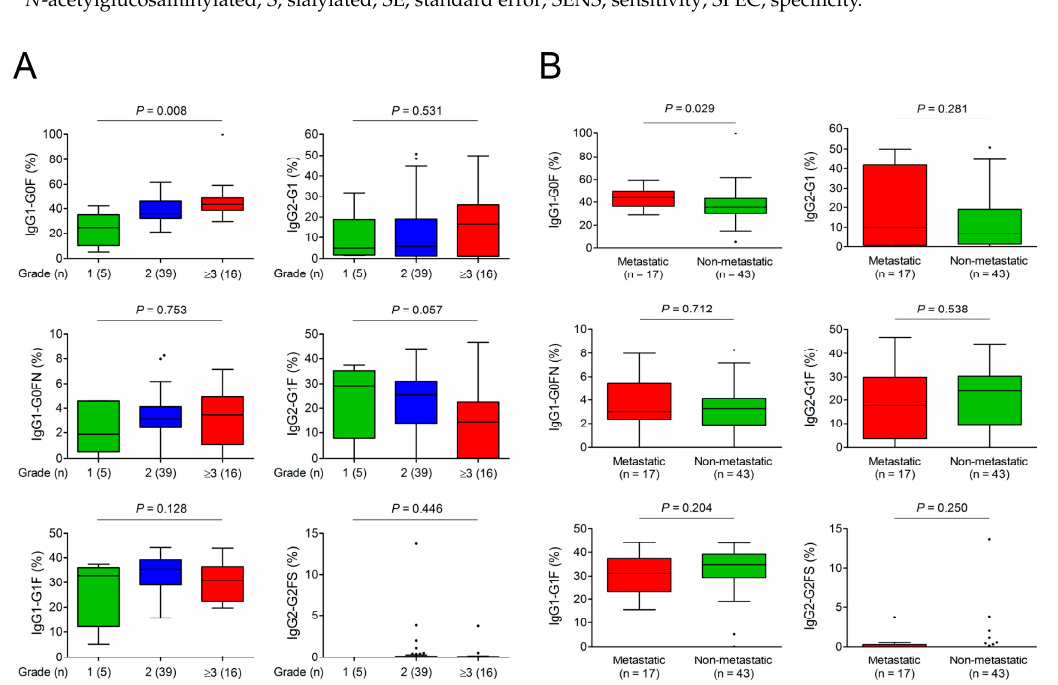
Table 3. Differentiation of cholangiocarcinoma by IgG 1 -Fc and IgG 2 -Fc N -glycoforms.